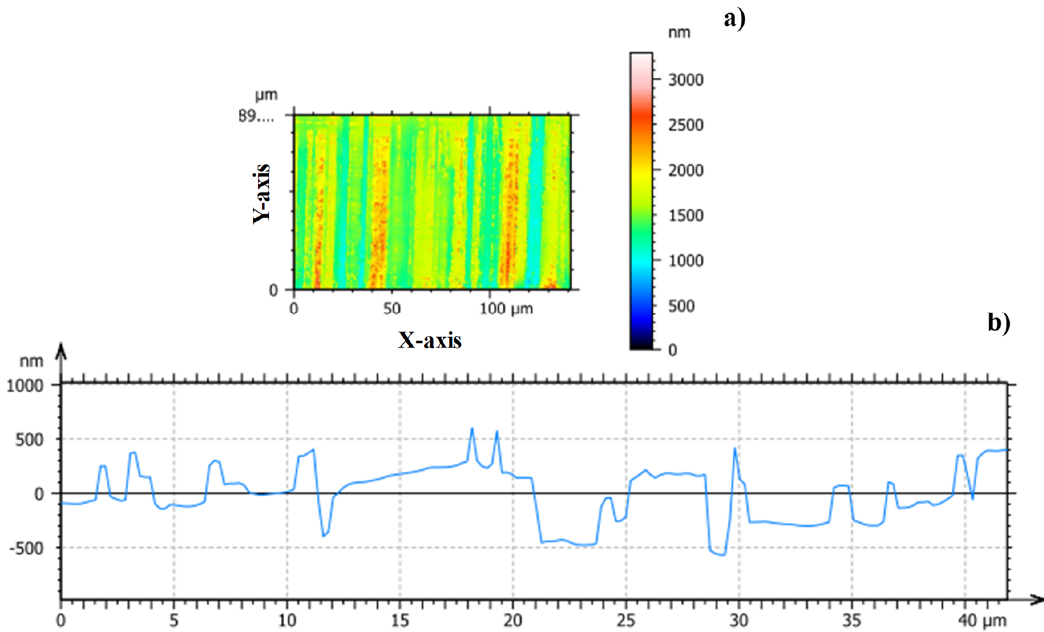
Figure 9. Measured profile of the hole surface pierced into the AISI316L sheet by white-light interferometry. ( a ) Two-dimensional surface angulation of the pierced hole surface and ( b ) lateral surface profile of the nano-textures transcribed onto the pierced hole.